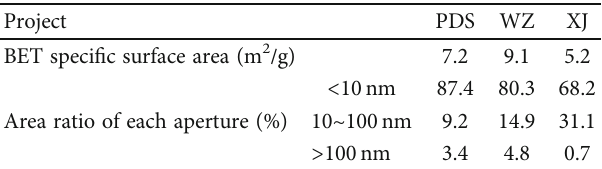
Table 2: Test results of pore speci fi c surface area by liquid nitrogen adsorption